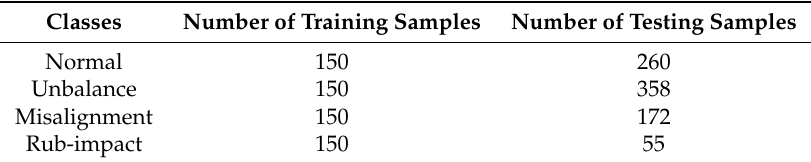
Table 1. Dataset setting.